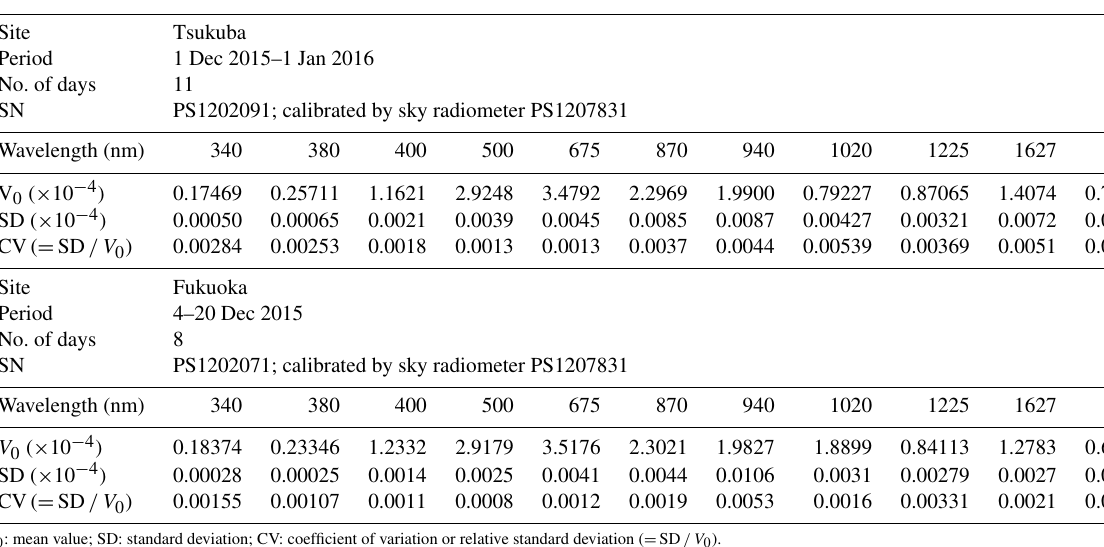
Table 3. Results of the calibration constant transferred from POM-02 (calibration reference) to POM-02 (Tsukuba) and POM-02 (Fukuoka) in December